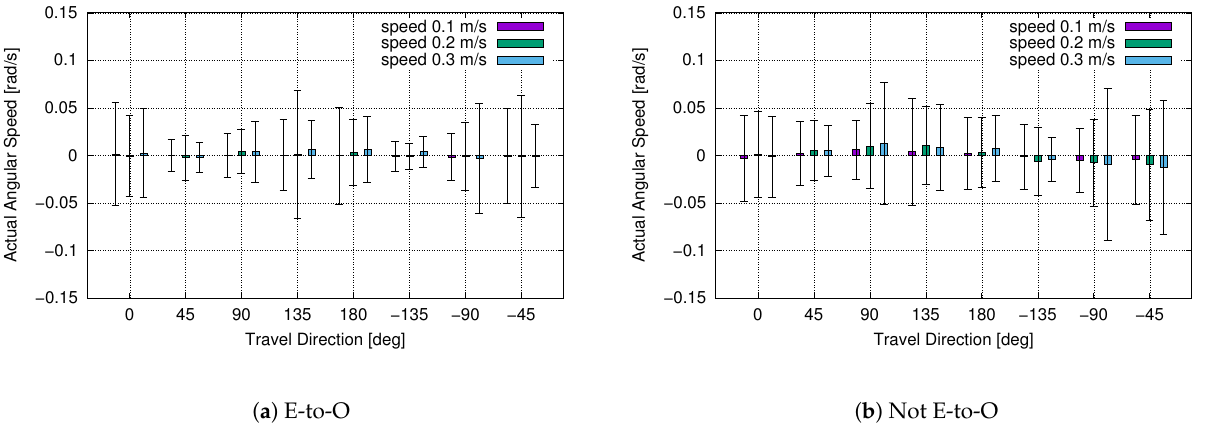
Figure 10. The robot’s actual angular speeds during each travel direction and command speed with 6-wheeled Omni wheel robots.